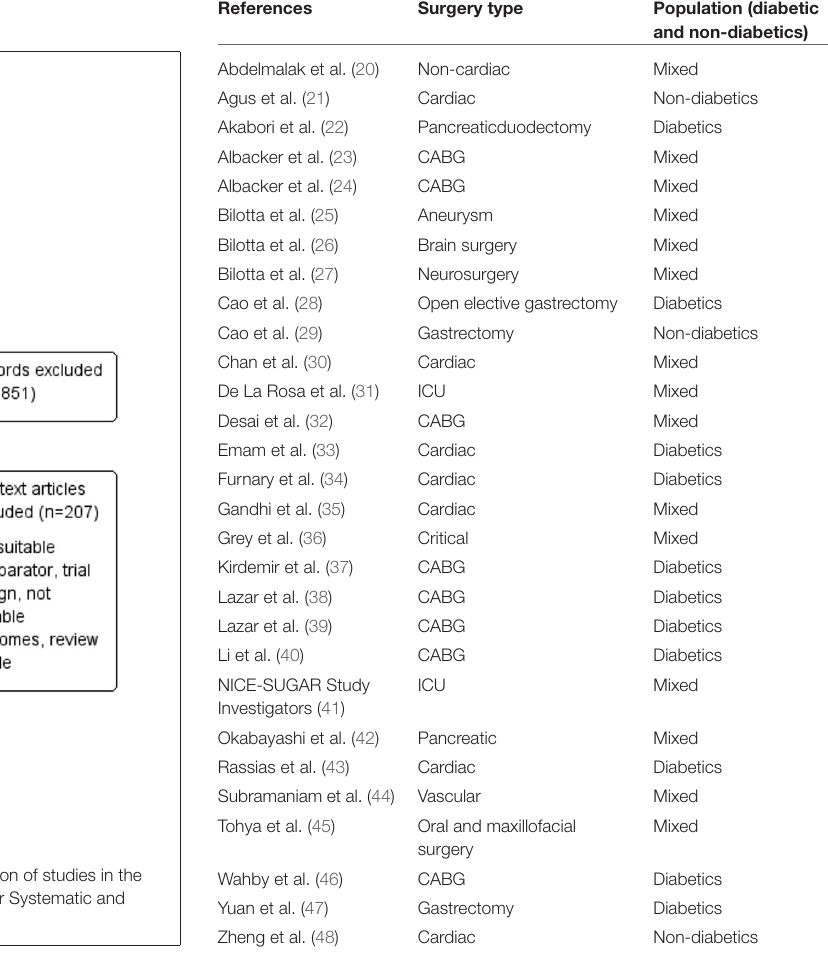
TABLE 1 | Demographic characteristics of the included studies.